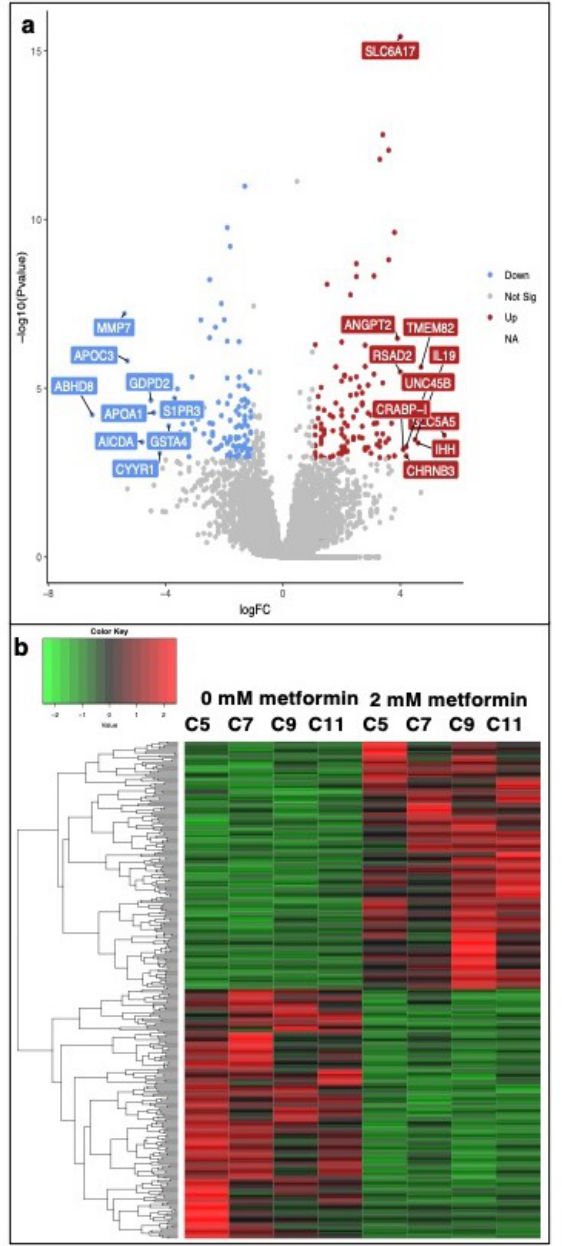
Figure 2. RNASeq analysis of mRNA extracted from metformin-treated COVCAR cells. COVCAR cell lines (C5, C7, C9, C11) were treated with 0, 0.5, 1, or 2 mM metformin for 24 h in ultra-low attachment culture wells. Total RNA was extracted and subjected to RNA sequencing Illumina sequencing. Statistical analysis was performed using DESeq2 in R v.4.1.0. to identify the differentially expressed genes (DEGs). ( a ) Volcano plot to indicate the differentially expressed genes (DEGs). Colored for |log2FC| > 1 and FDR < 0.05. ( b ) Heatmap of hierarchically clustered 365 DEGs between 0- and 2-mM metformin-treated COVCAR